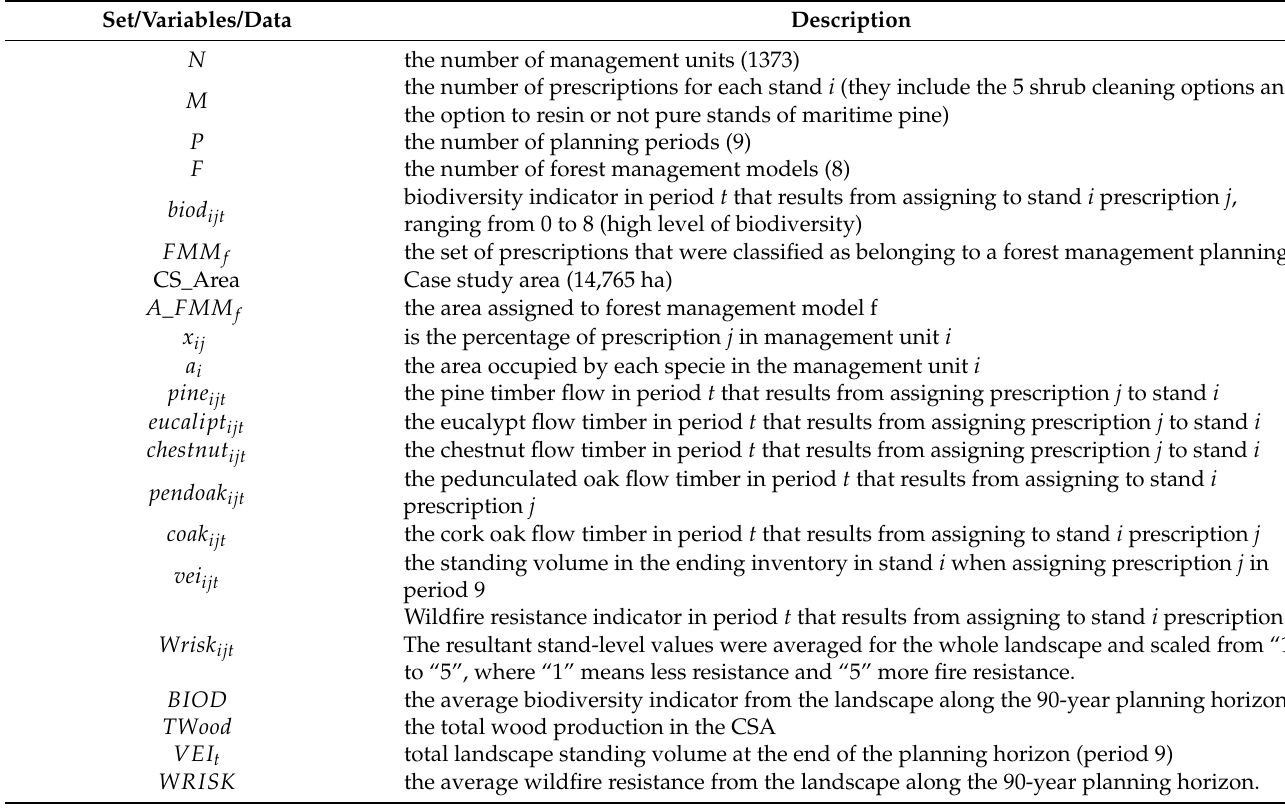
Table 4. Description of sets, variables and data applied in the linear programming (LP)-based optimization model. Set/Variables/Data